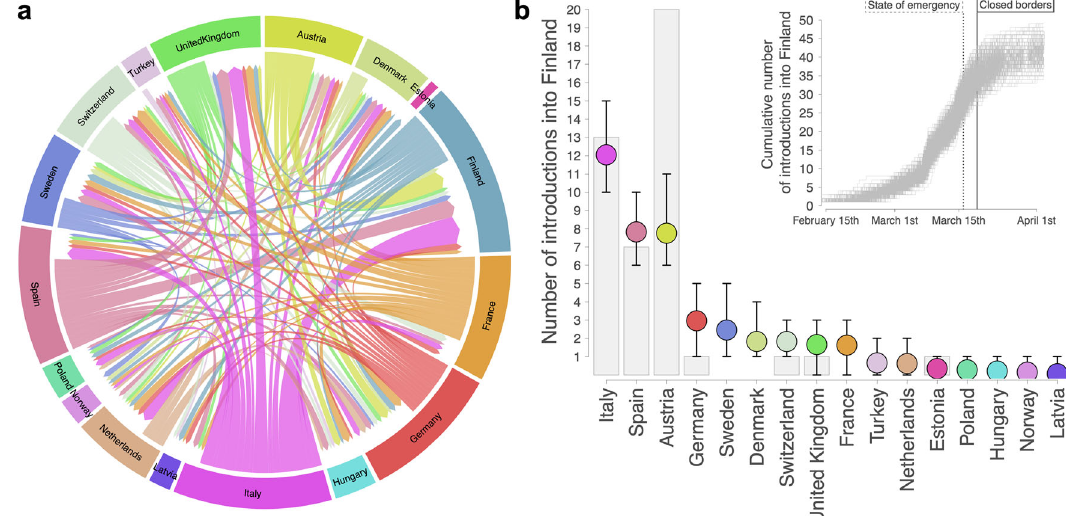
Fig. 3 Discrete phylogeographic reconstruction of SARS-CoV-2 introductions into Finland during the fi rst wave epidemic. a Circular migration fl ow plot based on the posterior expectations of the Markov jumps between 17 country-level locations, including Finland and 16 selected European countries. Migration fl ow out of a particular location starts close to the outer ring and ends with an arrowhead more distant from the destination location. b Mean and 95% highest posterior density (HPD) number of transitions to Finland from each of the 16 selected European countries, as estimated from 1,000 trees subsampled from the posterior distribution. Gray bars indicate the number of cases with travel history data returning from each country. Inset shows the cumulative number of introductions into Finland summarized from a posterior sample of phylogeographic trees. Dashed line indicates the day (16th of March) when the Finnish authorities declared a state of emergency due to COVID-19. Full line indicates the day (19th of March) when the Finnish authorities announced a restriction of passenger traf fi c at Finland ’ s